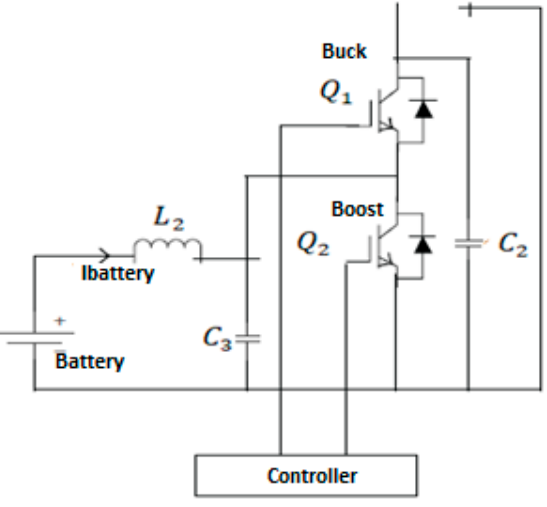
Figure 2. Structure of the DC–DC bidirectional converter.